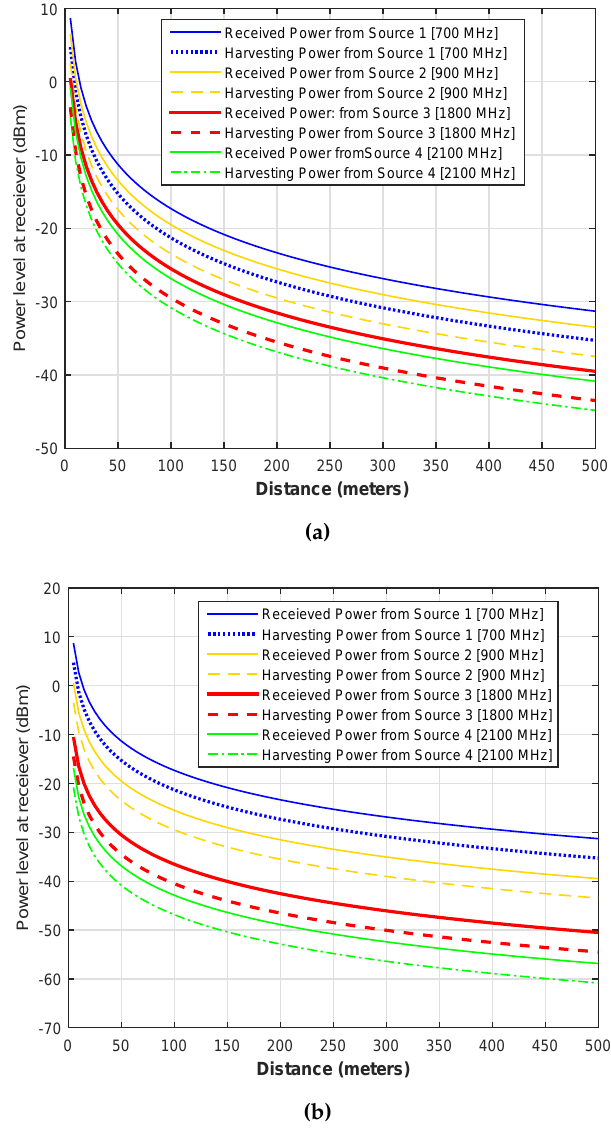
Figure 4. Received and harvested powers at receiver. ( a ) Same power and link gains of RF sources; ( b ) Different power and link gains of RF